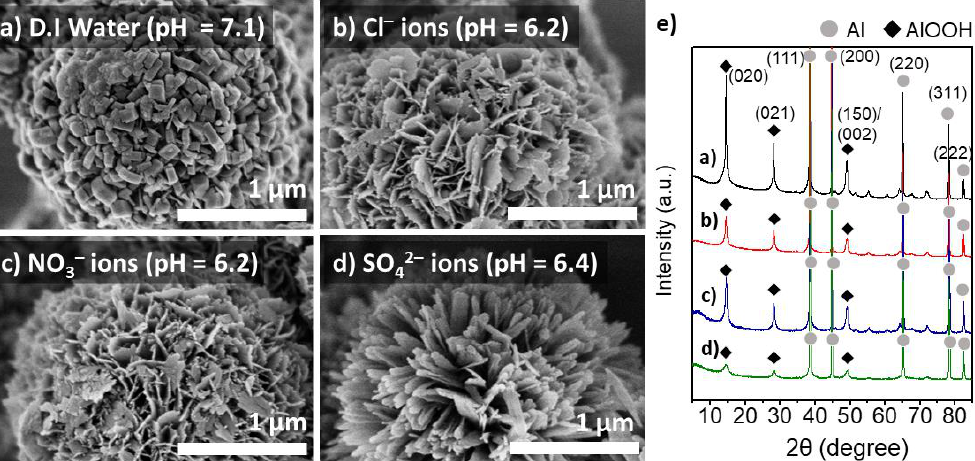
Figure 3. SEM micrographs of the Al@AlOOH core–shell samples prepared by HTR at 423 K for 5 h in D.I.-H 2 O ( a ) and the aqueous solution of NH 4 Cl ( b ), NH 4 NO 3 ( c ), and (NH 4 ) 2 SO 4 ( d ), respectively. The XRD pattern of the samples ( e ).